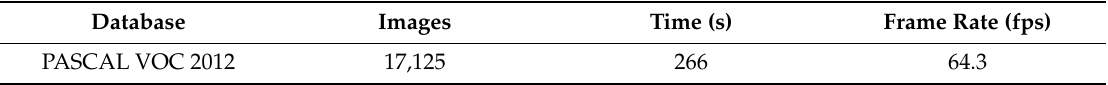
Table 4. Frame rate result of the proposed method for the PASCAL VOC 2012 database.